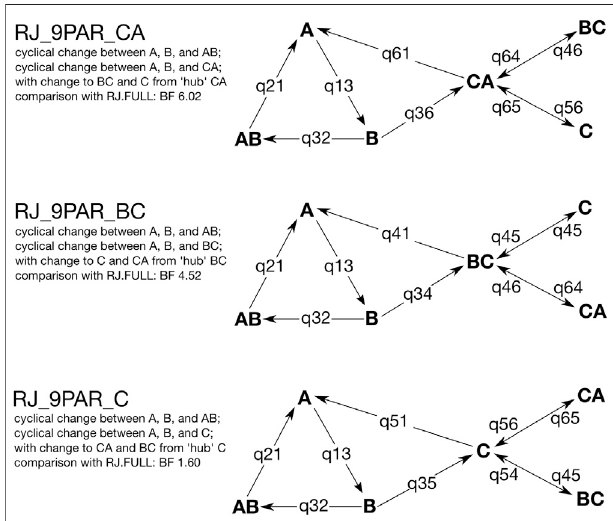
FIGURE 8 | Visualizations of transition rate parameters included in models RJ_9PAR_CA, RJ_9PAR_BC, and RJ_9PAR_C.